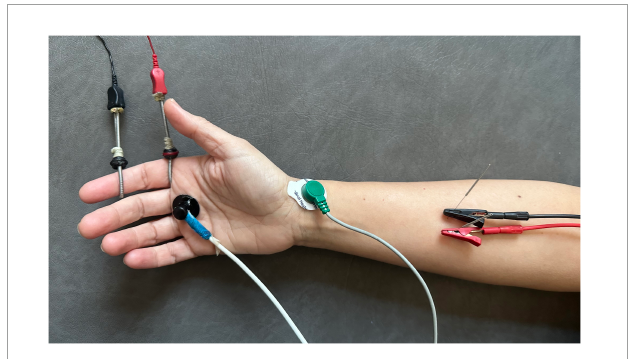
FIGURE1 Procedure of application of percutaneous electrical stimulation with high-frequency alternating currents